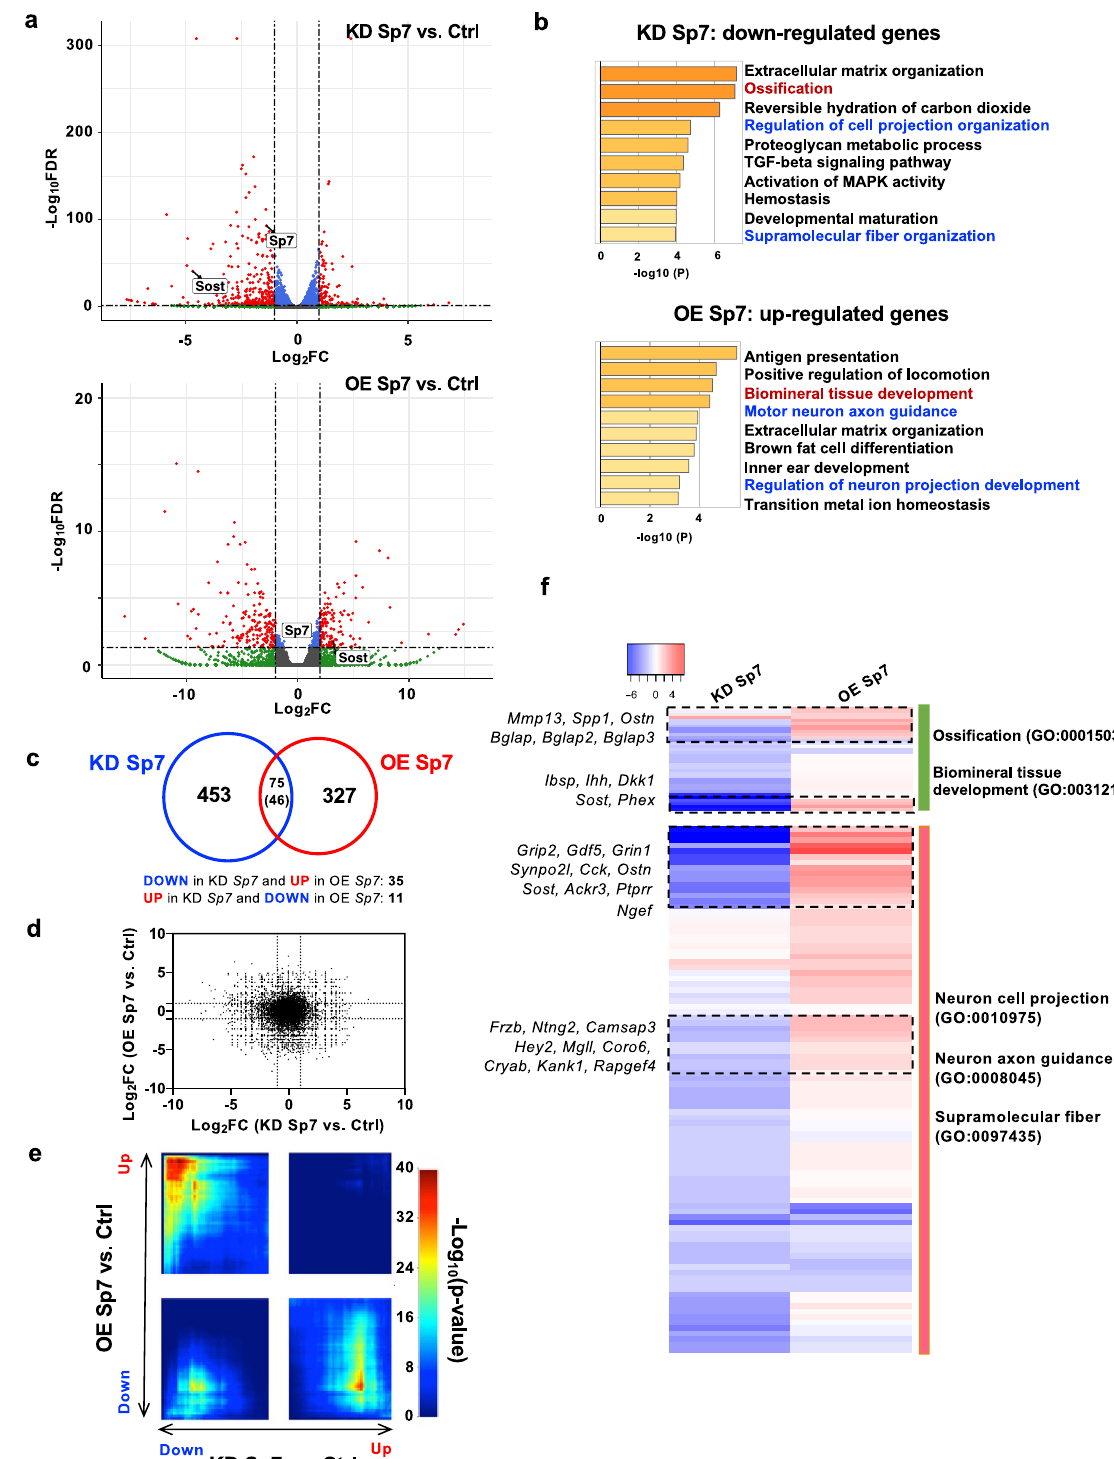
(1000 nM), supporting a mechanism of action of osteocrin via enhancement of CNP signaling. This relationship was apparent in both control MC3T3 and Ocy454 cells (WT MC3T3 con vs OSTN Pearson correlation coef fi cient = 0.31; WT MC3T3 CNP vs CNP + OSTN Pearson correlation coef fi cient = − 0.31) and shSp7 cells. Further analysis of distinct morphologic features driving differences between cells treated with OSTN + CNP and cells treated with CNP alone support a role for OSTN